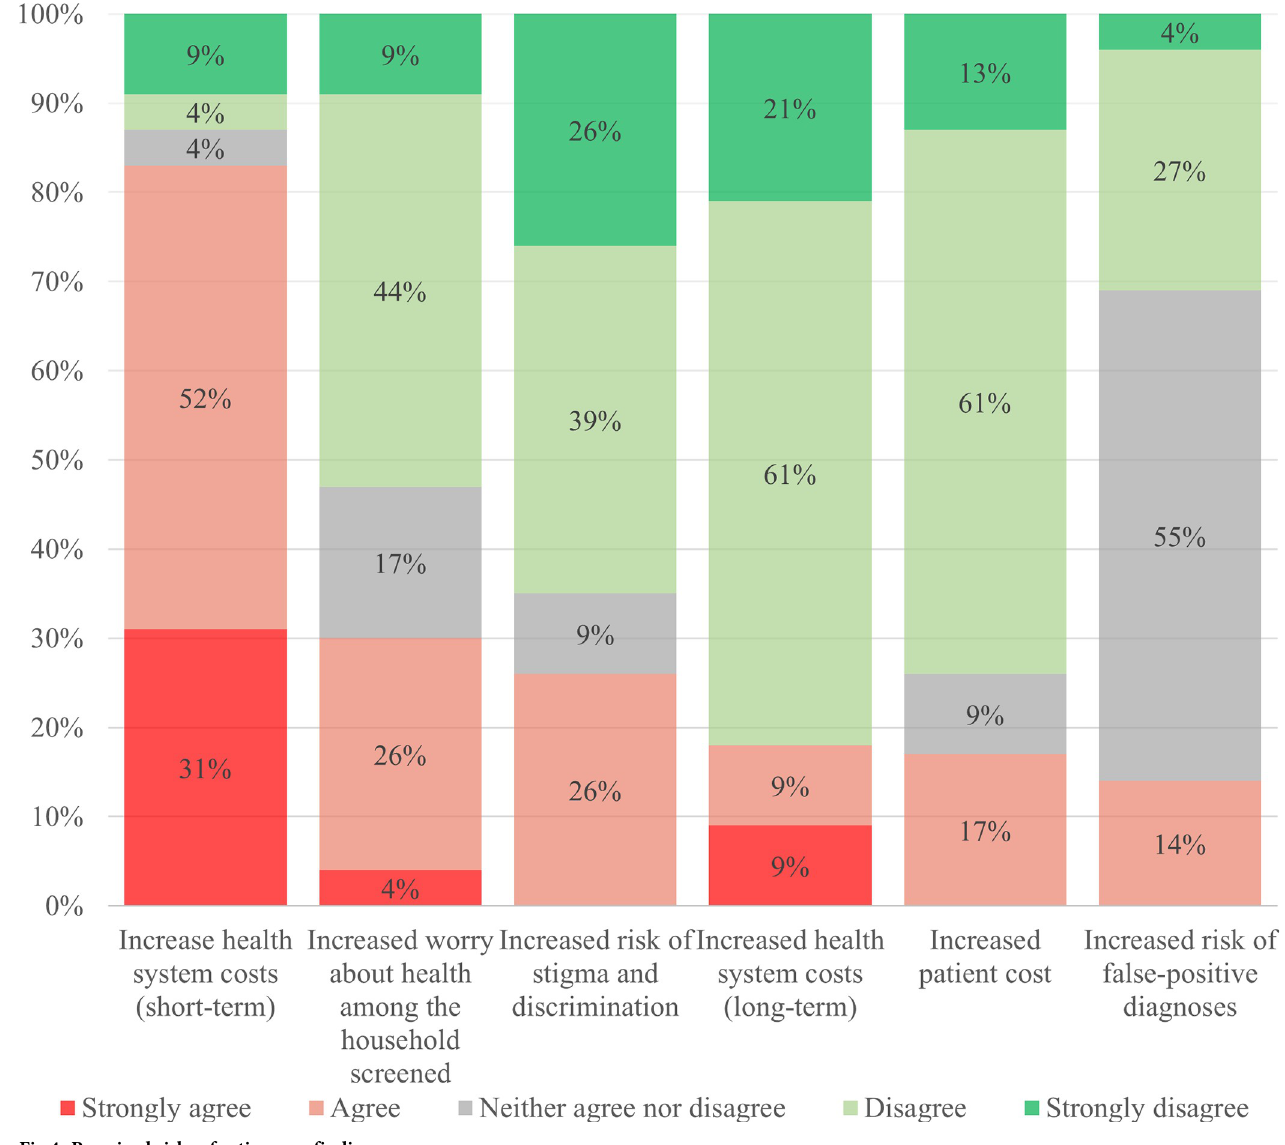
Fig 4. Perceived risks of active